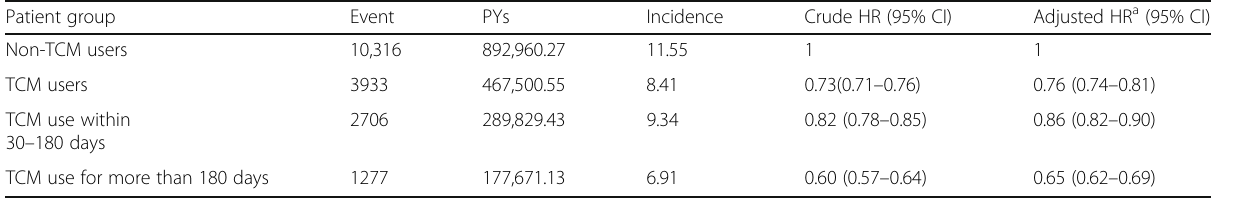
Table 2 Risk of dementia for HTN subjects with and without TCM Patient group